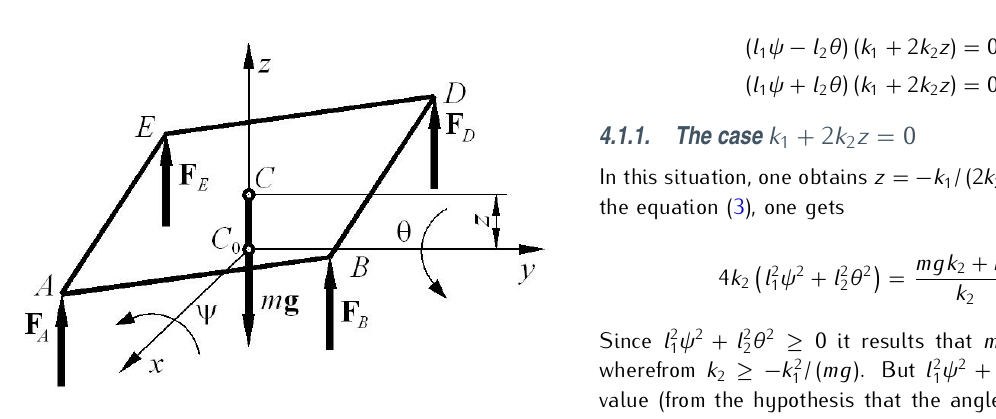
Figure 2. The equilibrium positions.